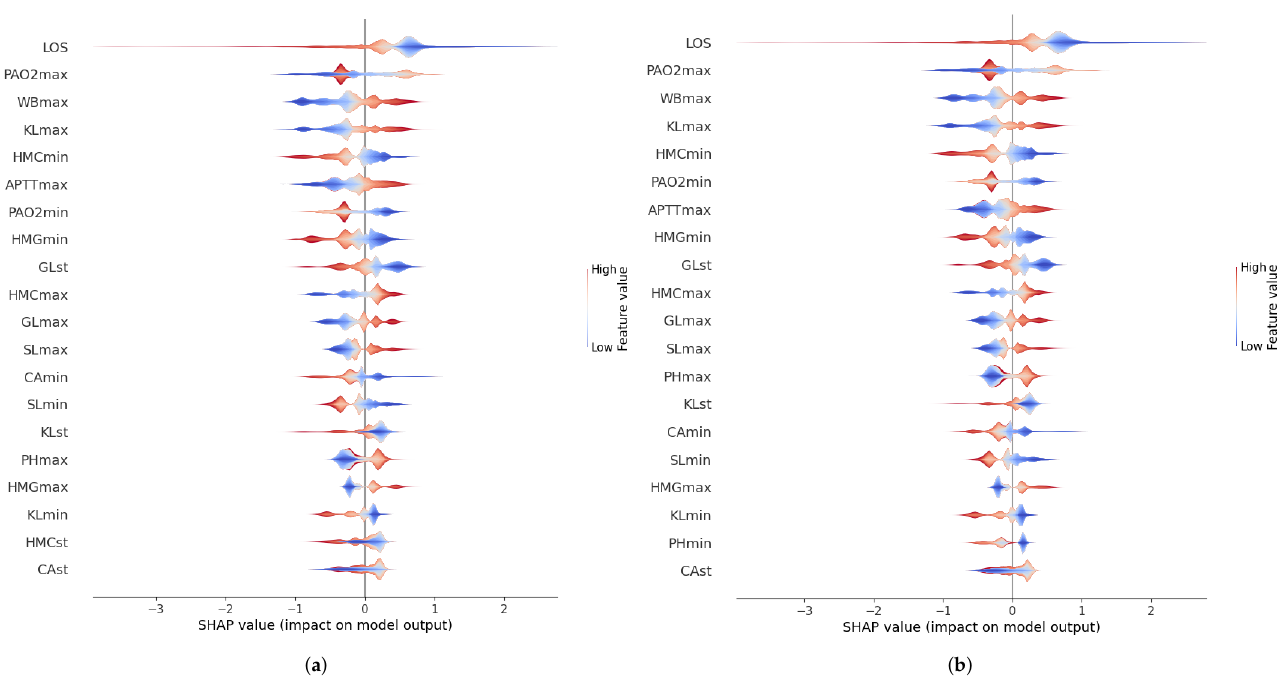
Figure 8. SHAP summary plot using the different optimization criteria: AUROC and AUPRC. ( a ) Using AUROC as an optimization criterion. ( b ) Using AUPRC as an optimization